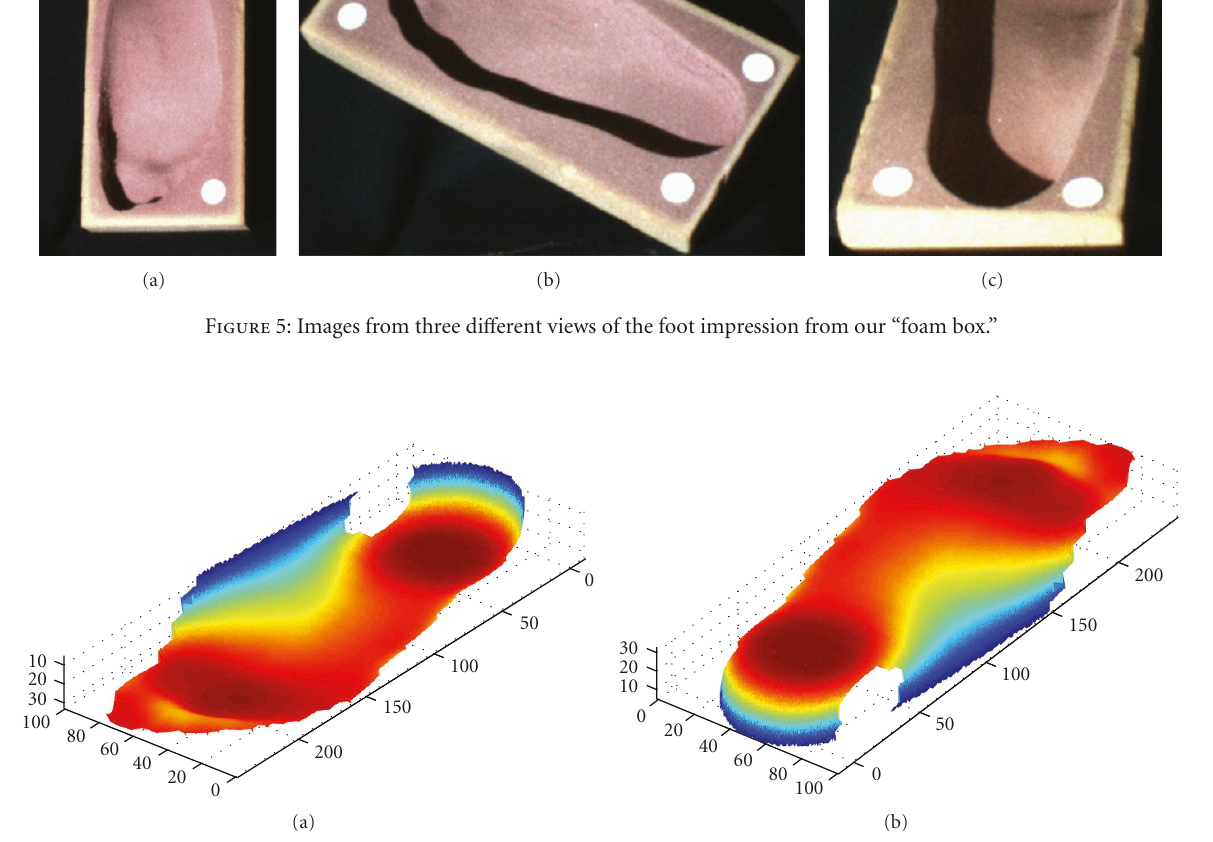
Figure 6: Impression from the foam box reconstructed from the single view: (a) the top perspective (b) the bottom perspective. Colors correspond to the di ff erent depth of the impression. The distribution of the colors is defined using jet color map in Matlab.